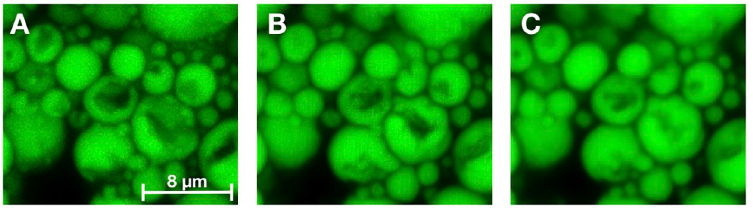
Fig 7. Comparison of lipid defect reconstructions between the models. (A) Ground truth fluorescence image, (B) Output from the model trained with L better delineation of the lipids and an improved reconstruction of the lipid defects/dents than in (C). Images are displayed with the same dynamic range for visualization purpose.